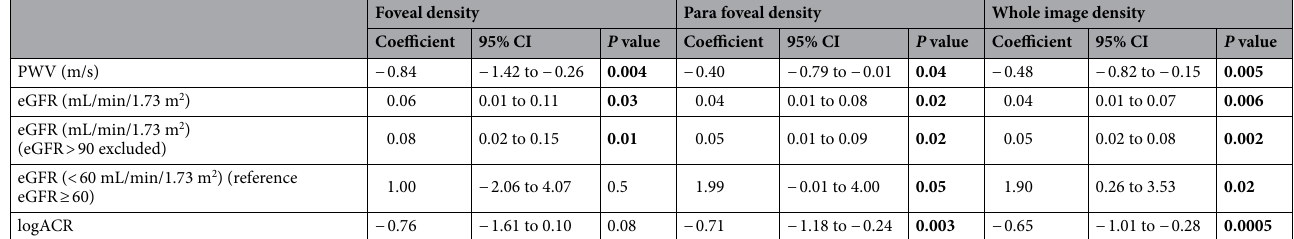
Table 4. Alternative model adjusting for HbA1c. Alternative adjusted model results for foveal density, replacing the covariate ‘type 2 diabetes” with “HbA1c” (glycated hemoglobin). CI, confidence interval; PWV, carotid-femoral pulse wave velocity; eGFR, estimated glomerular filtration rate; ACR, albumin-to-creatinine ratio. Data were analyzed using linear regression models with generalized estimating equation. Bold face indicates statistically significant after multiple testing